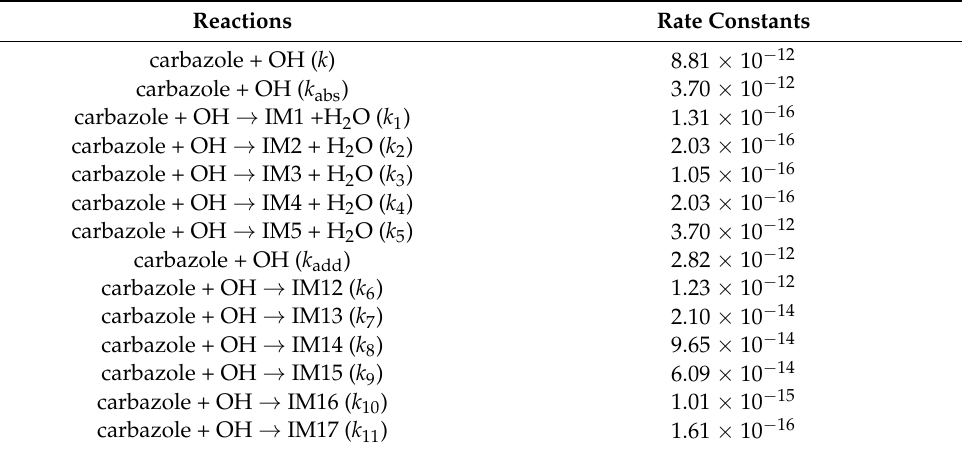
Table 1. RRKM calculated rate constants (in cm 3 molecule − 1 s − 1 ) for the elementary reactions involved in the OH-initiated oxidation degradation of carbazole at 298 K and 1